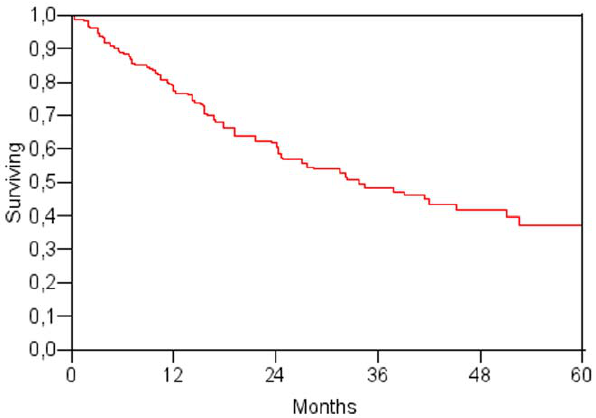
Figure 2. Overall survival curve.